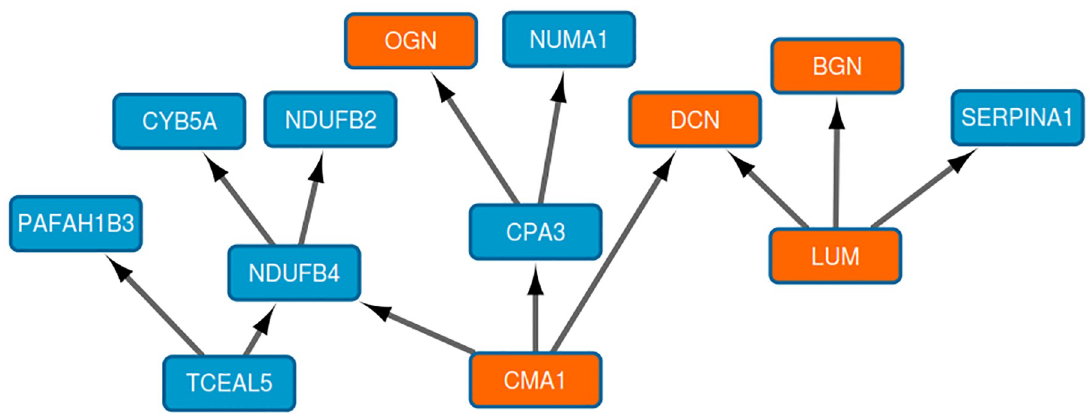
Fig 3. Component 13. Orange nodes: Proteins related to extracellular matrix ontology.